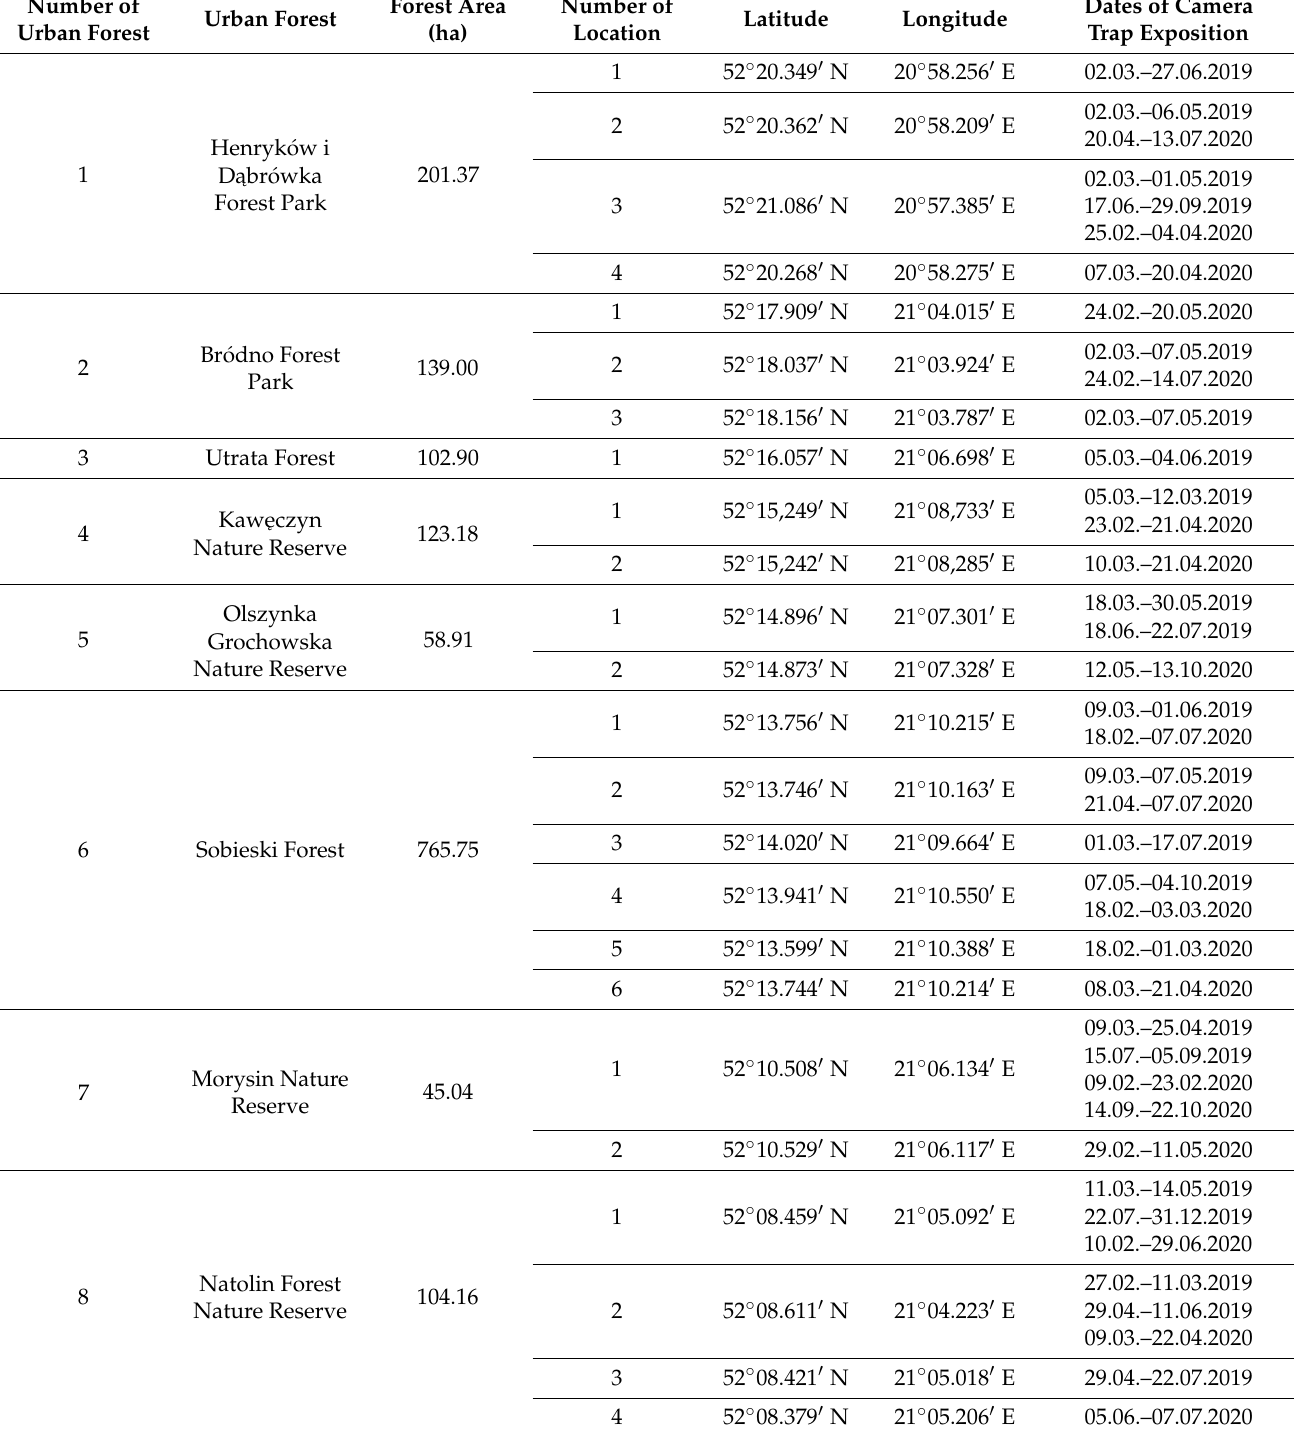
Table A1. Characterization of urban forests where the camera traps were distributed in urban forests of Warsaw in the